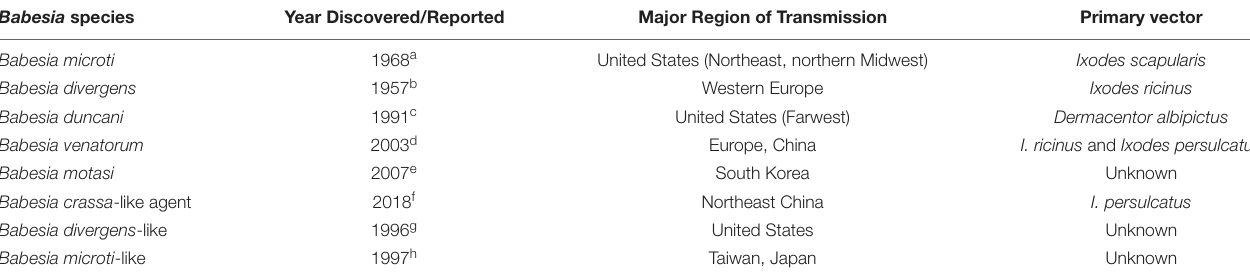
TABLE 1 | Babesia that cause human babesiosis.